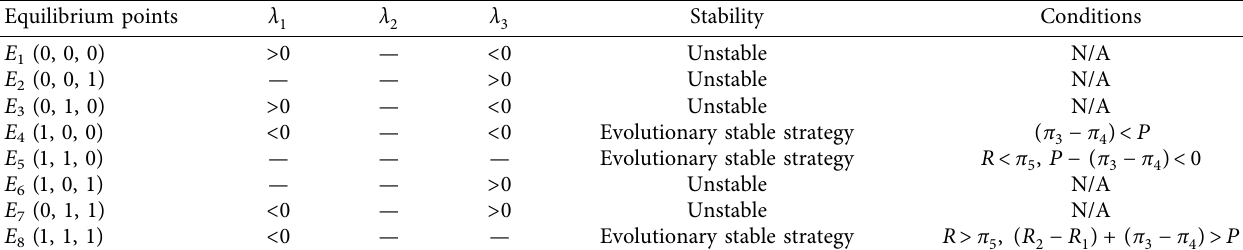
Table 3: Stability of the equilibrium points in Case